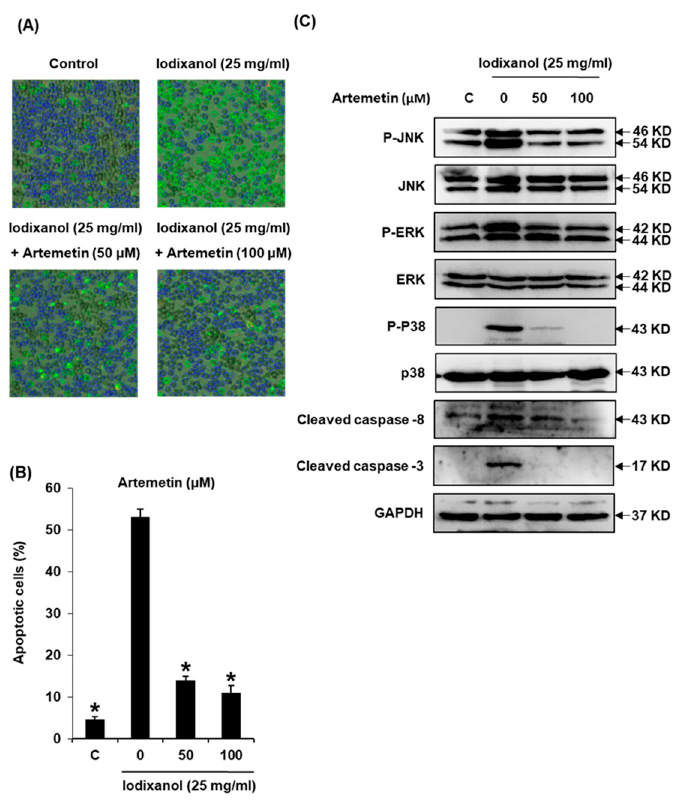
Figure 7. Effects of artemetin on apoptosis in LLC-PK1 cells exposed to iodixanol (25 mg/mL) for 24 h by image-based cytometric assay and western blot analysis: ( A ) representative images for apoptosis detection; ( B ) percentage of Annexin V-positive-stained apoptotic cells; and ( C ) protein expression of Bcl-2, Bax, cleaved caspase-8, cleaved caspase-3 and JNK. * p < 0.05 compared to the not-treated